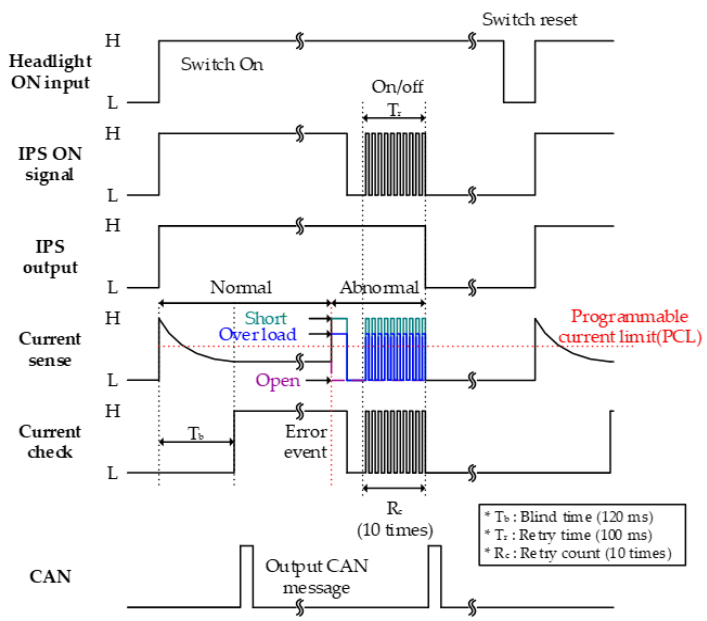
Figure 10. Status switching to improve the operational stability by checking the abnormal state of the load during load. load during load.